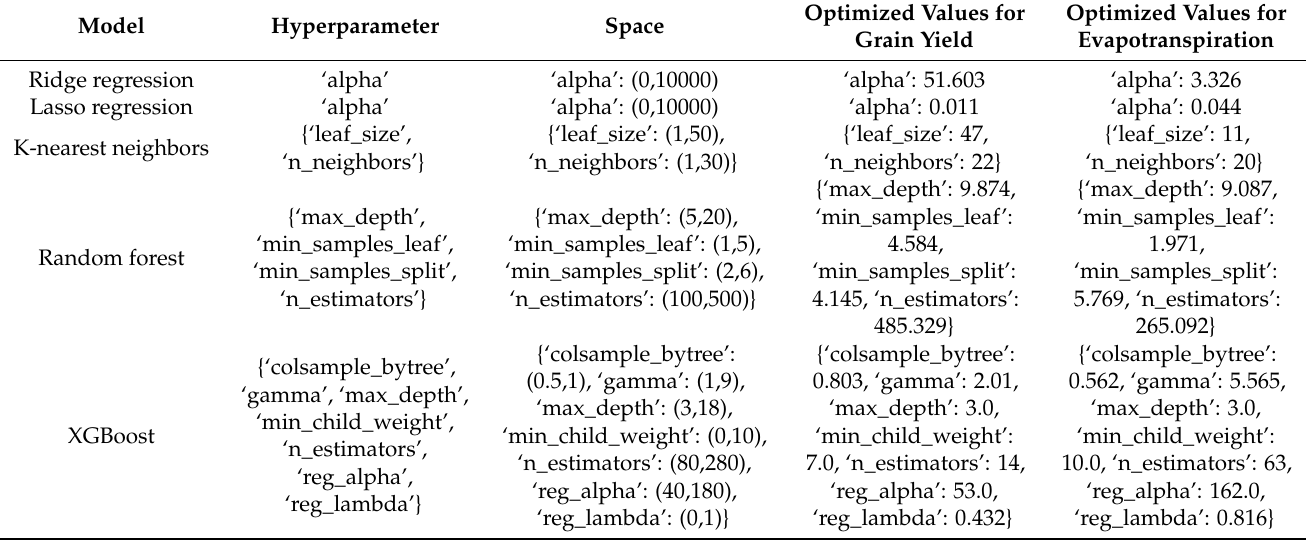
Table 3. Hyperparameters space and optimized values for several machine learning